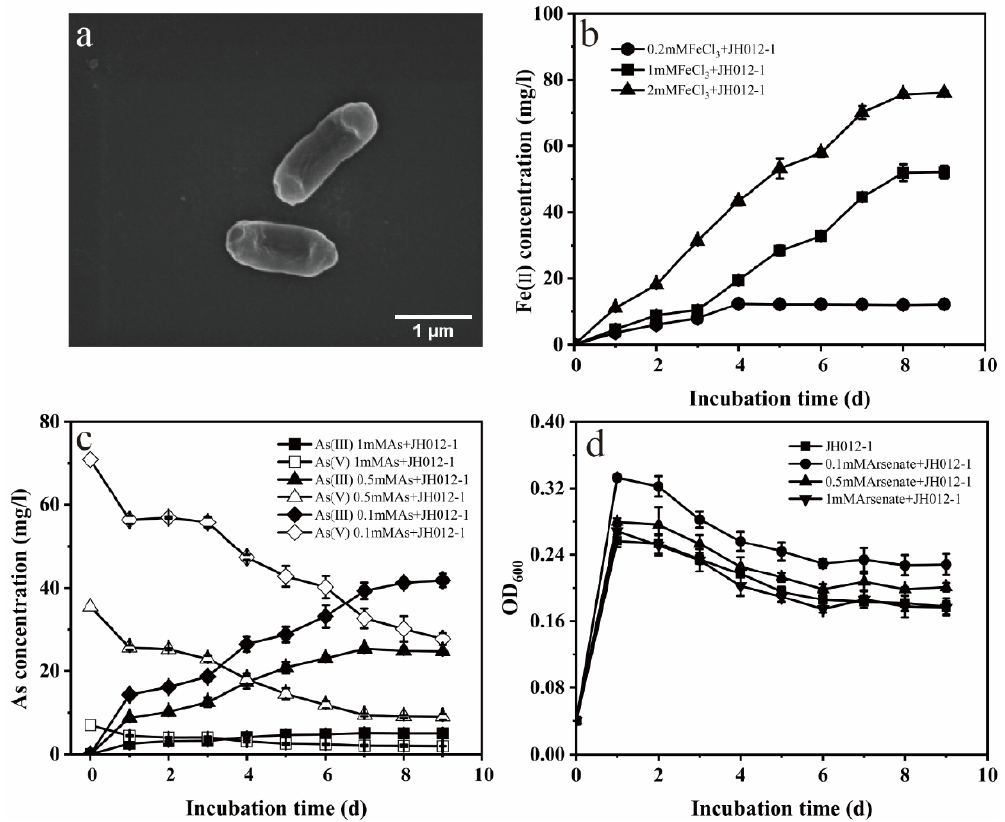
Figure 4. Morphology of strain JH012-1 ( a ). Iron ( b ) and arsenate ( c ) reduction ability of JH012-1; growth of JH012-1 under different concentrations of arsenate ( d ).